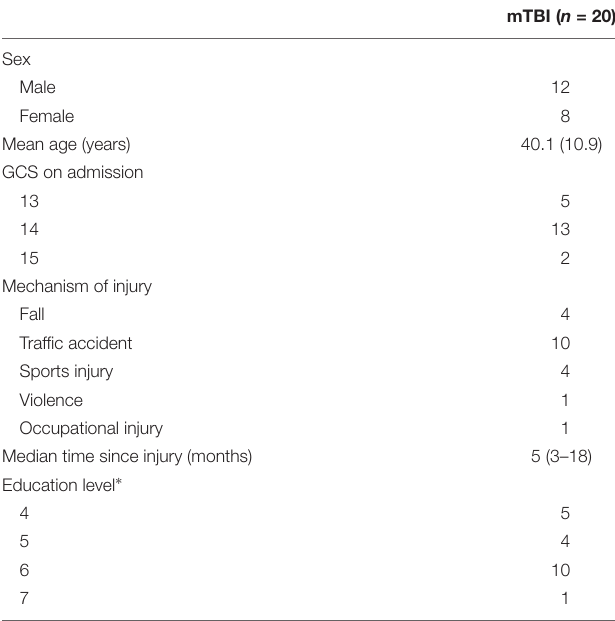
TABLE 1 | Demographics and injury characteristics of mTBI